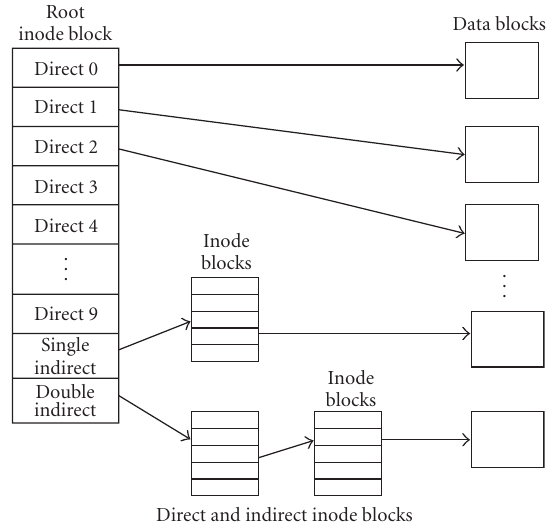
Figure 3: UNIX Inode